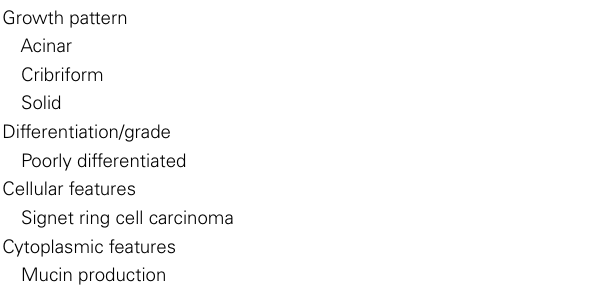
Table 2 | Morphological characteristics of theALK-positive